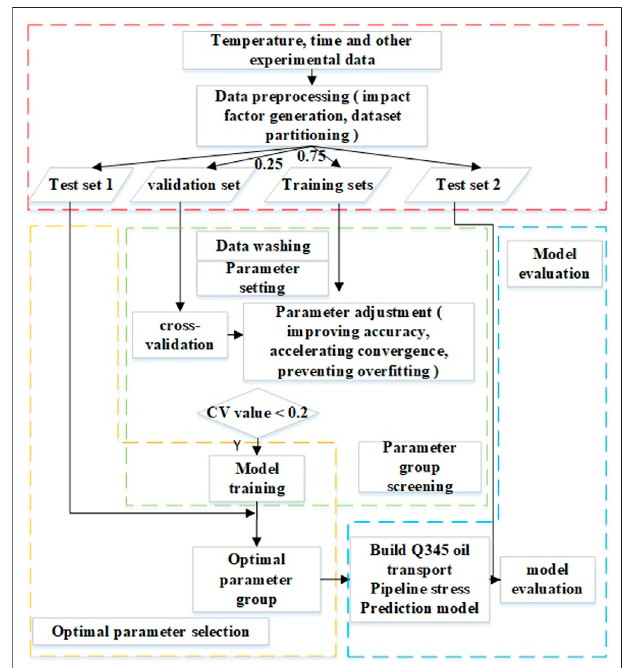
FIGURE 7 | Modeling process based on the XGBoost algorithm.